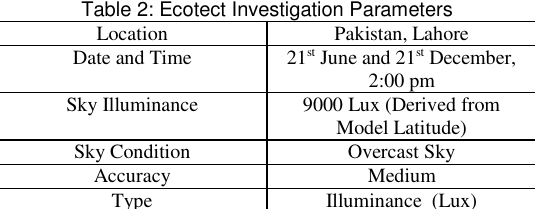
Table 2: Ecotect Investigation Parameters Location